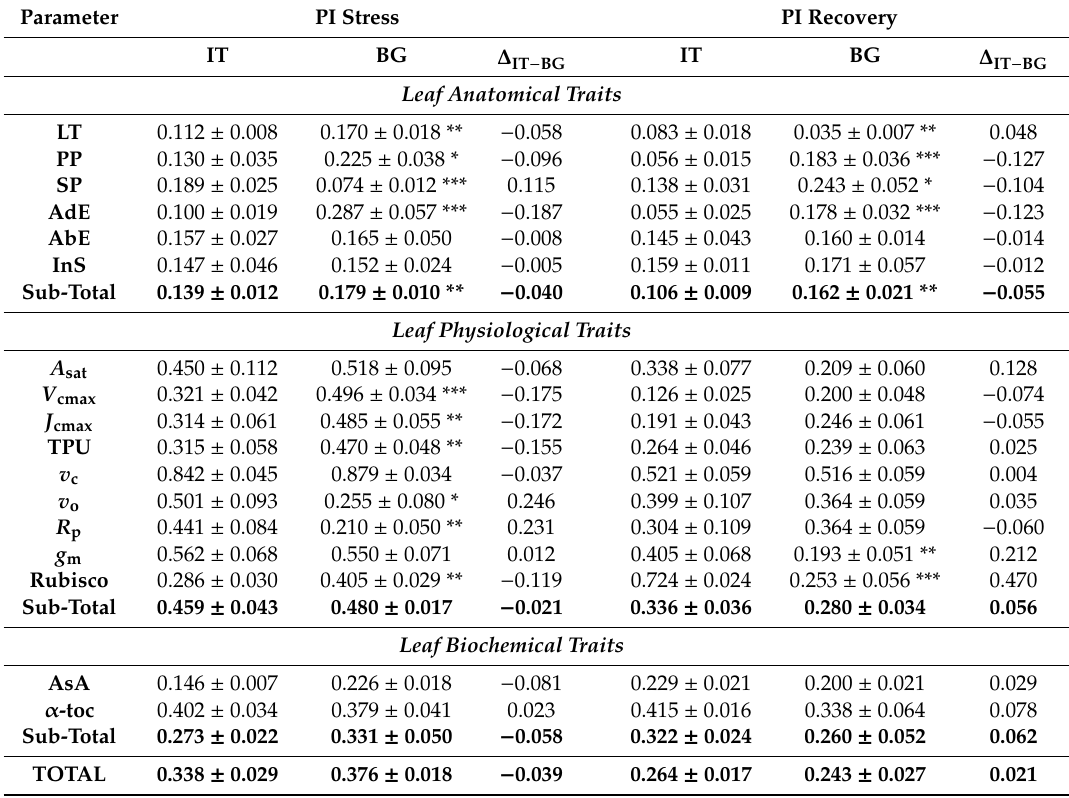
Table 1. Phenotypic plasticity index of Italian (IT) and Bulgarian (BG) P. orientalis populations in response to drought (PI stress) and after re-watering (PI recovery) for the variables of Figures